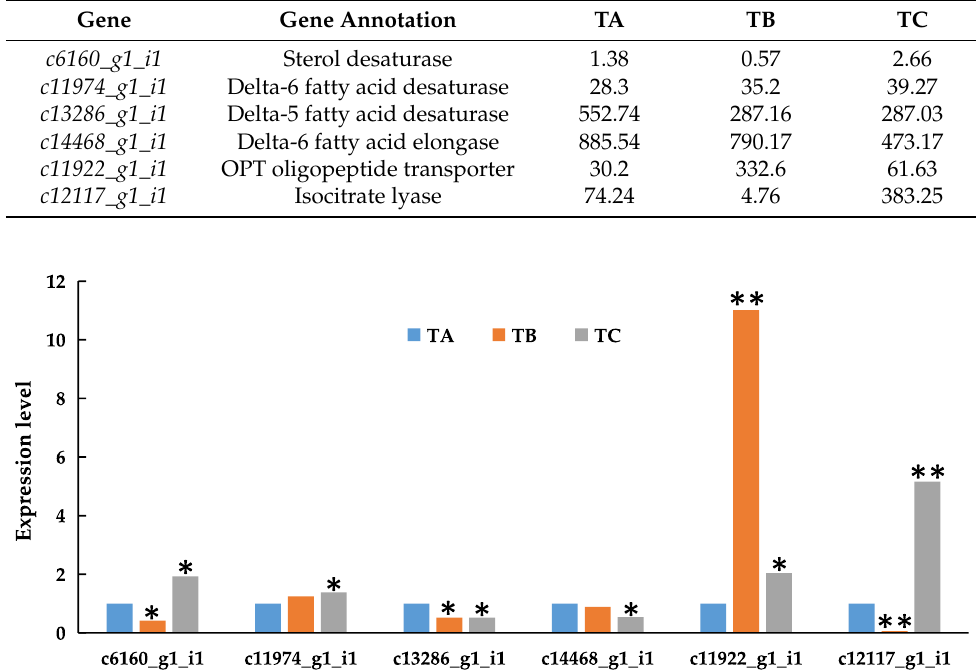
Figure 10. The qRT-PCR analysis of the expression patterns of six differentially expressed genes (DEGs) revealed in the three groups (i.e., TA, TB, and TC) of Mortierella alpina . Symbols “*” and “**” indicate the significant difference set at p values less than 0.05 and 0.01, respectively, in comparison to TA.